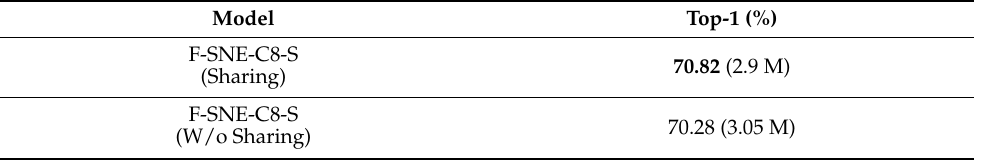
Figure 2. Performances were compared among proposed structures. Averaged top-1 accuracies of transfer learning were used. Circle size corresponds to FLOPs of each structure. Table 8. The cases of code sharing and unsharing were compared using the ImageNet-1k dataset. The numbers in brackets denote the number of total parameters for each